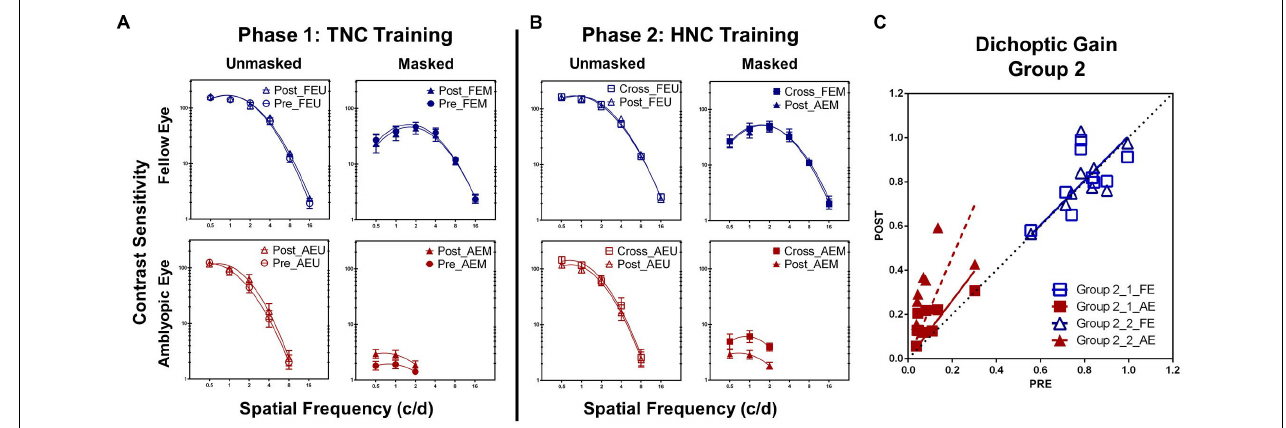
FIGURE 4 | (A) CSFs under different conditions in Group 2 before (Pre, circle) and after (Post, triangle) the TNC training (Phase 1). (B) CSFs under different conditions in Group 2 after the TNC training (Post, triangle) and after crossed over to the HNC training (Cross, square) (Phase 2). (C) Dichoptic gains for the two eyes in Group 2 before training ( x -axis) is plotted against those after training ( y -axis) for the two phases. The diagonal unity line represents unchanged dichoptic gain between pre- and post-training assessment.